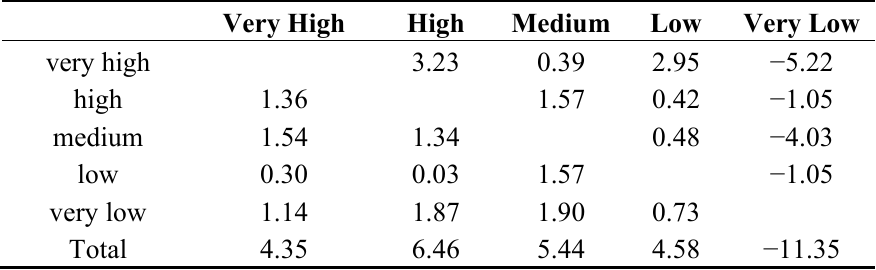
Table 10. Squared deviances estimated based on observed and expected frequencies —Dano study